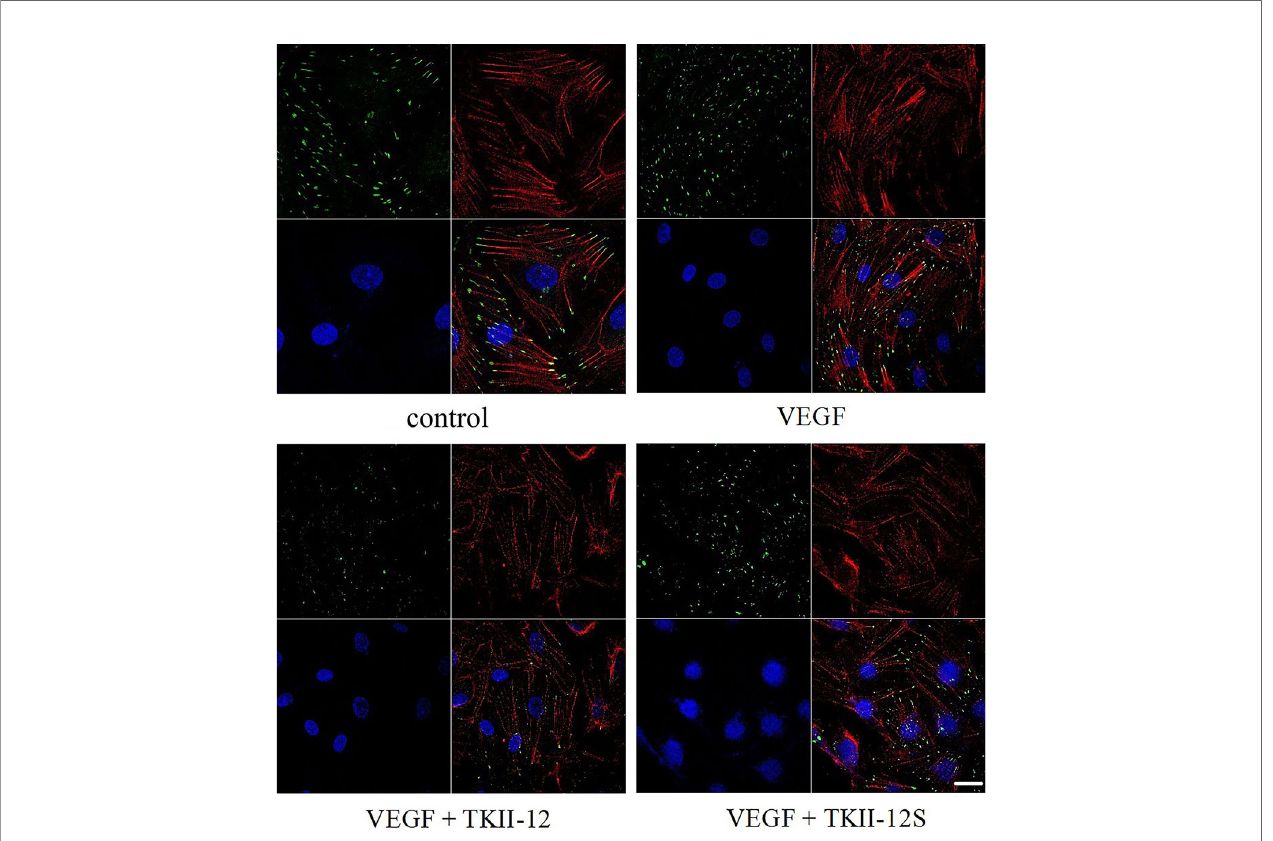
FIGURE 5 | Effects of TKII-12 on vascular endothelial growth factor (VEGF)-induced formation of actin stress fi bers and focal adhesion complexes in HRMECs. HRMECs were immunostained with an antivinculin antibody and stained with TRITC-conjugated phalloidin and DAPI. The scale bar is 20 m m.